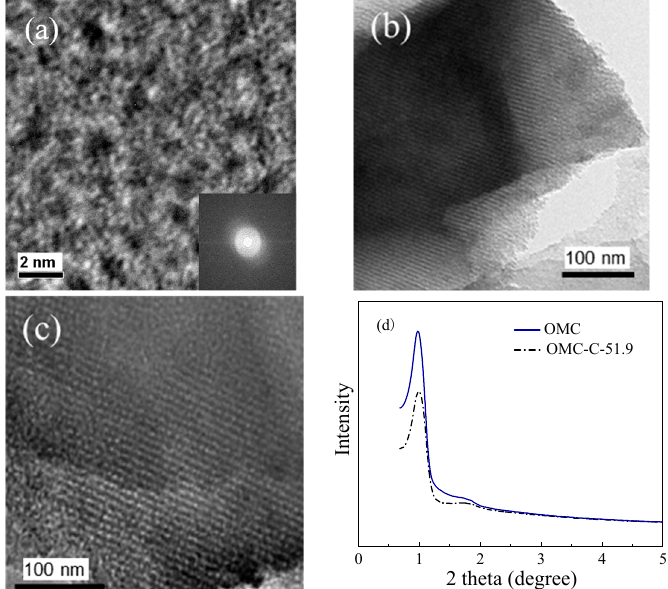
Figure 2. Morphological characterizations of hierarchical porous carbons. TEM micrographs of ( a ) AC-C-50.8 (inset: Fast Fourier diffractogram), ( b ) OMC, and ( c ) OMC-C-51.9; ( d ) Small-angle XRD patterns of OMC and OMC-C-51.9.